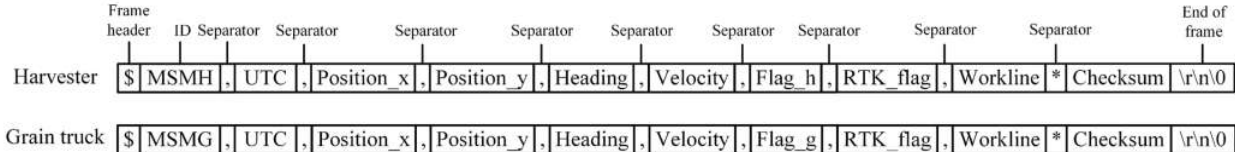
Table 2. Main parameters of DTU and Core board.